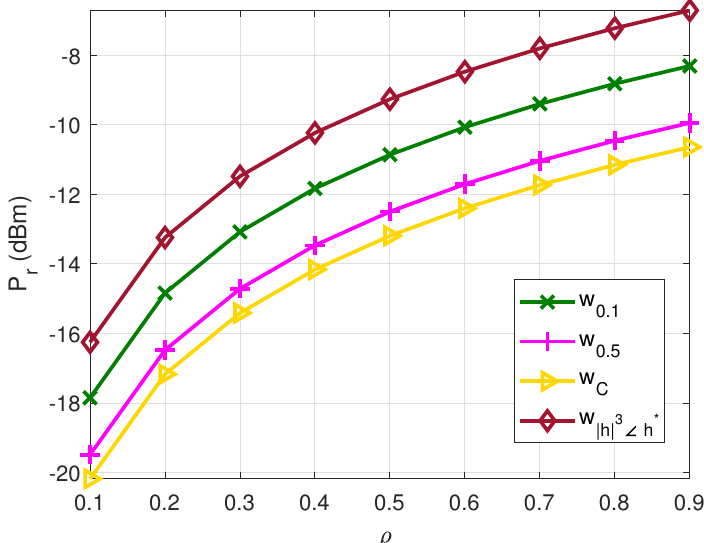
Figure 9. Received power P r as a function of the splitting coefficient ρ using the proposed pre-equalizers in an 8-tone signal based SWIPT system of bandwidth 1